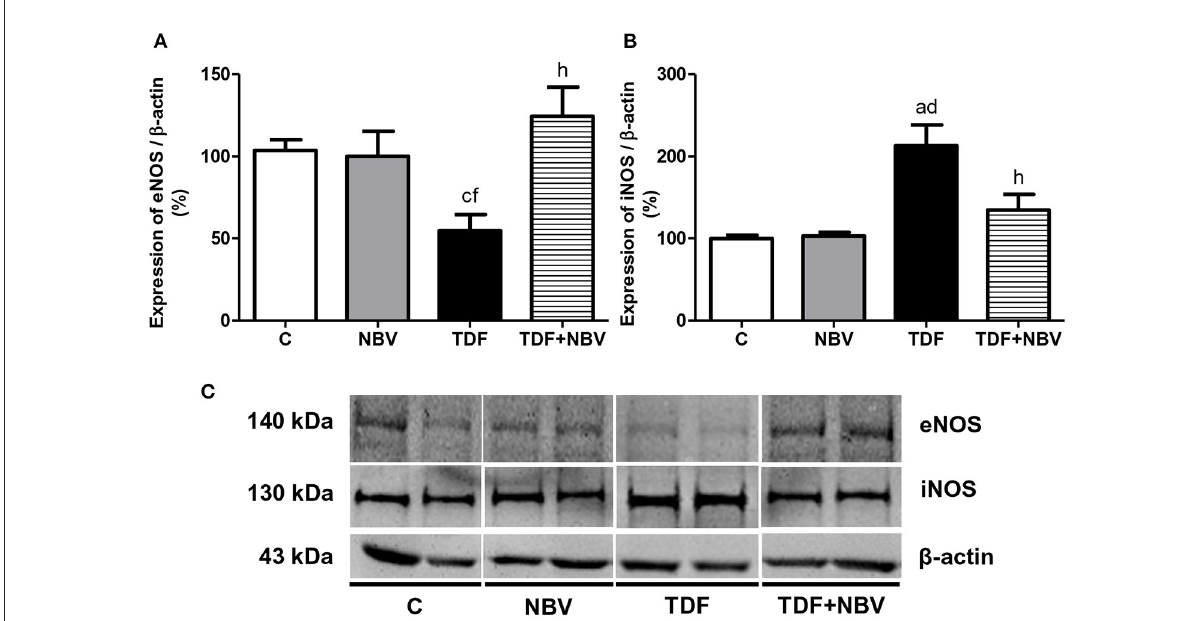
FIGURE1 Semiquantitative immunoblotting for eNOS and iNOS expression in rat kidney tissue. (A) eNOS densitometric analysis of samples from C ( n = 7), NBV ( n = 7), TDF ( n = 8) and TDF + NBV ( n = 8) rats. (B) iNOS densitometric analysis of samples from C ( n = 7), NBV ( n = 7), TDF ( n = 8) and TDF + NBV ( n = 8) rats. (C) Representative immunoblots which reacted with anti-eNOS and anti-iNOS revealing bands of 140 and 130kDa, respectively. Values are means ± SEM. a p < 0.001, c p < 0.05 vs. C; d p < 0.001, f p < 0.05 vs. NBV; h p < 0.01 vs. TDF. C, control; NBV, Nebivolol; TDF,